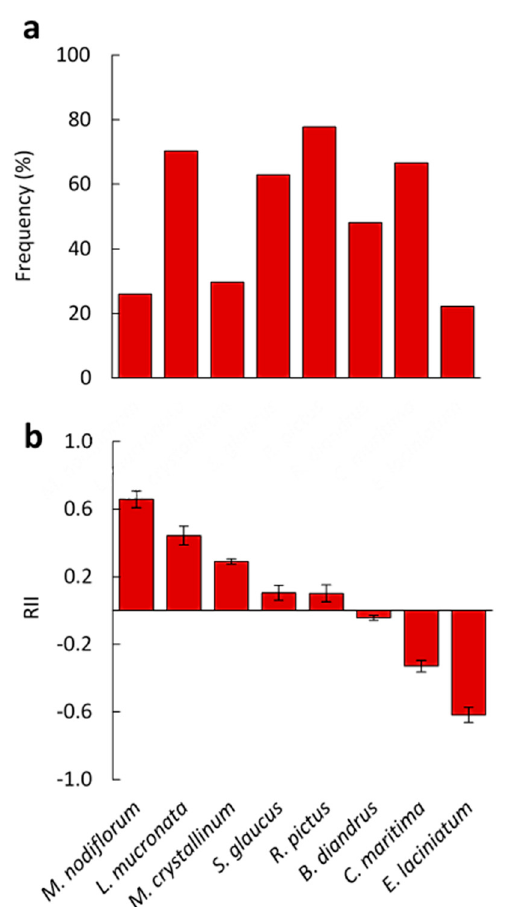
Figure 3. Interaction of C. polygonoides shrubs (old and young shrubs) with the eight selected associated species. ( a ) Frequency percentage of the eight selected species (highest one). ( b ) Relative interaction index (RII) values based on biomass (dry weight, n = 20).